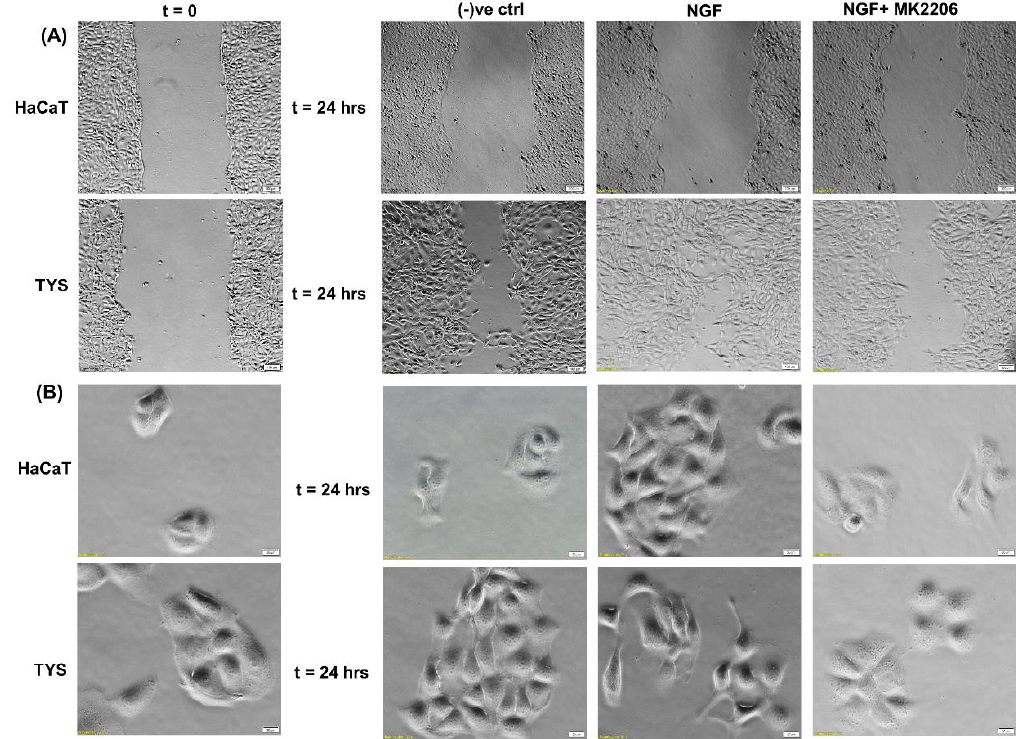
Figure 7. Effect of NGF on oral cancer cell migration. ( A ) NGF with or without the inhibitor was used in the wound healing assay for 24 h. NGF stimulated higher numbers of TYS to migrate in the wound healing assay in comparison to the negative control. The Akt inhibitor, MK2206, effectively blocked TGF β -induced oral cancer cell migration. Normal keratinocytes (HaCaT) were not stimulated to migrate in response to TGF β . Serum-free medium was used as the negative control. Images were captured at t = 0 and 24 h at 50 × magnification. ( B ) Cells were plated at low densities to form small colonies for the scatter assay and were then treated with the test conditions for 24 h. NGF stimulated TYS cells to migrate away from the compact colonies and a mesenchymal-like cell morphology was observed in the scattered cells. MK2206 effectively blocked NGF-induced scattering of the oral cancer cells. HaCaT cells were not stimulated to scatter in response to NGF. Serum- free medium was used as the negative control. Images were captured at t = 0 and 24 h at 200× magnification. An inverted microscope (Olympus IX70, Tokyo, Japan) with a brightfield camera (SC50) was used to capture the images and CellSense software (Olympus) was used to process the images. The experiments were carried out more than 3 times.